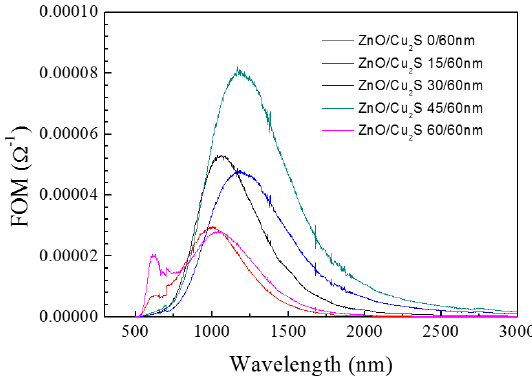
Figure 17. The figure of merit of ZnO/Cu 2 S/glass complex films for different thickness.